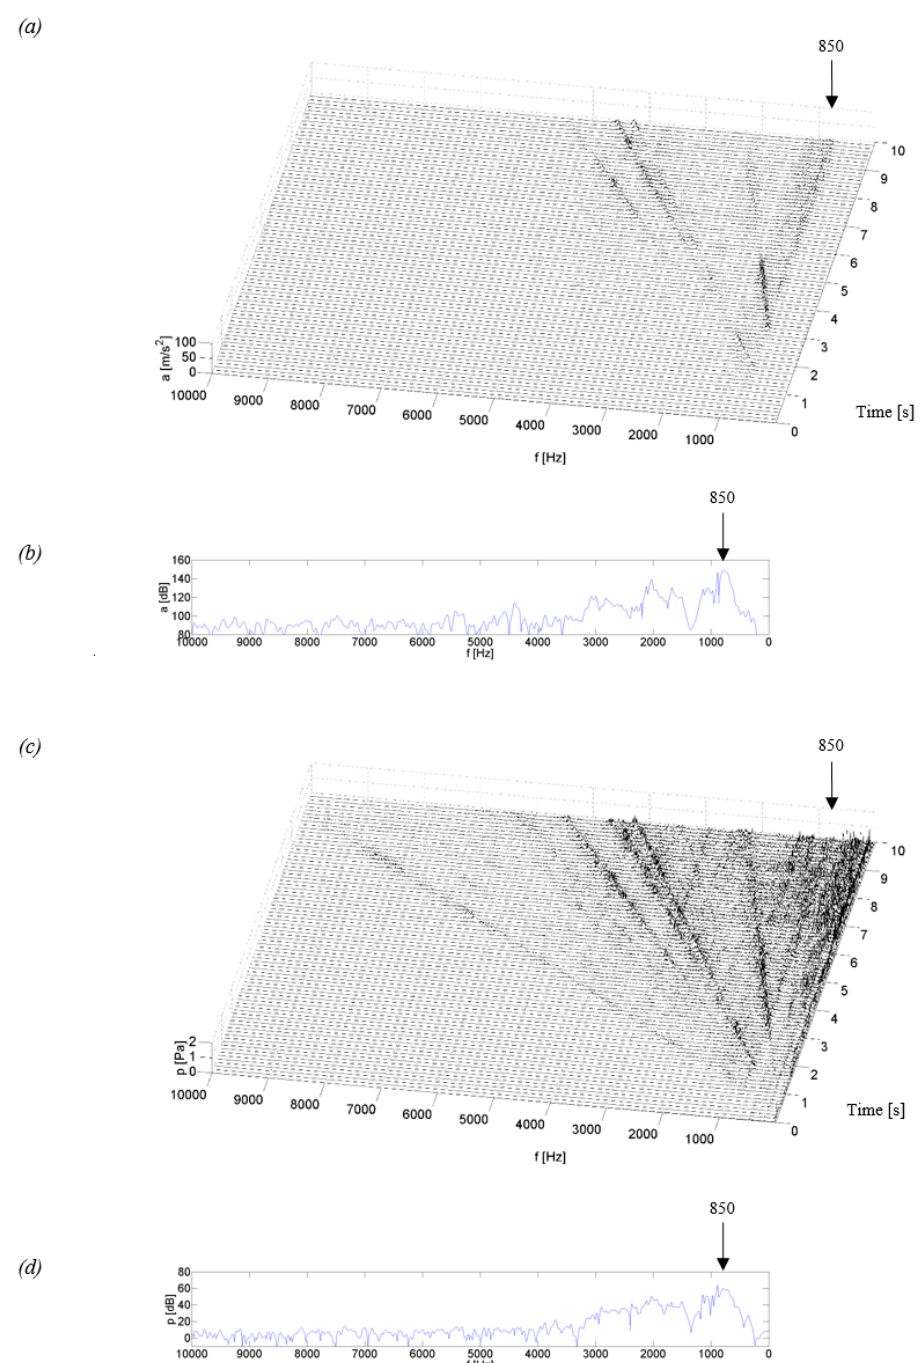
Figure 6. Test results for the K_2 housing: ( a ) time-frequency distributions of vibration acceleration (P_5), ( b ) vibration response (P_5), ( c ) time-frequency distributions of acoustic pressure ( H ), ( d ) acoustic response ( H ).